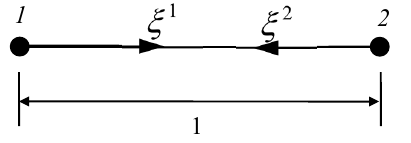
Figure 3. Dual-coordinate systems for a typical layer or element.